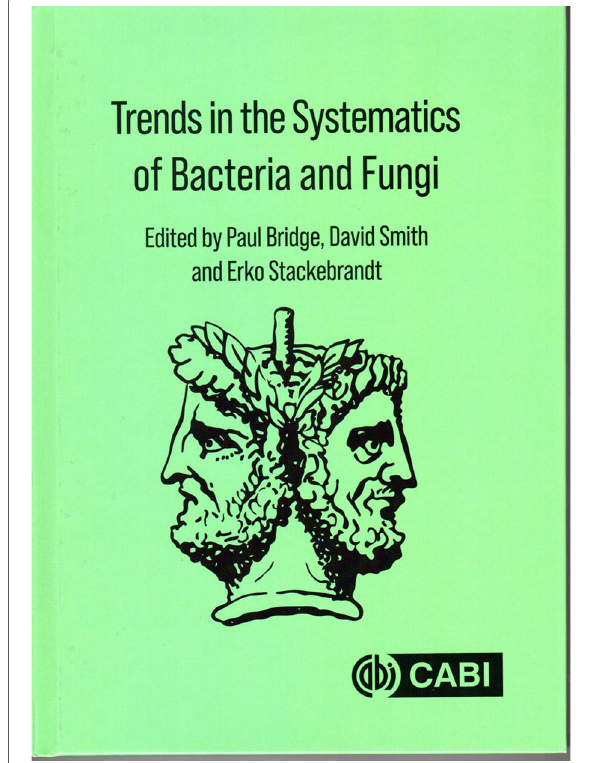
Fig. 37 Trends in the systematics of Bacteria and Fungi